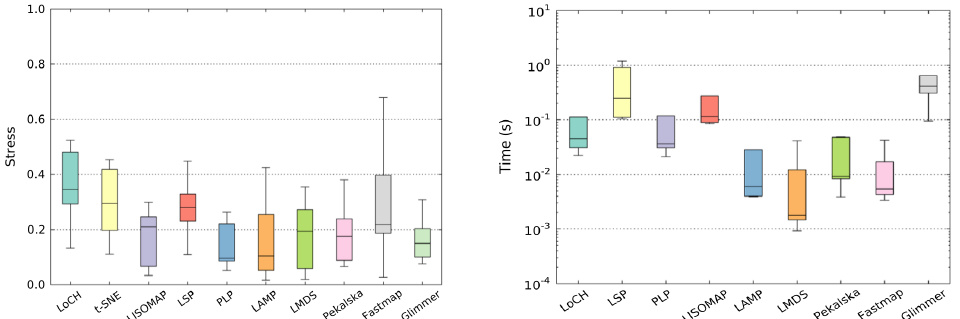
Figure 4. Comparative charts presenting stress and running times between some multidimensional projection techniques. Source: Fadel et al.